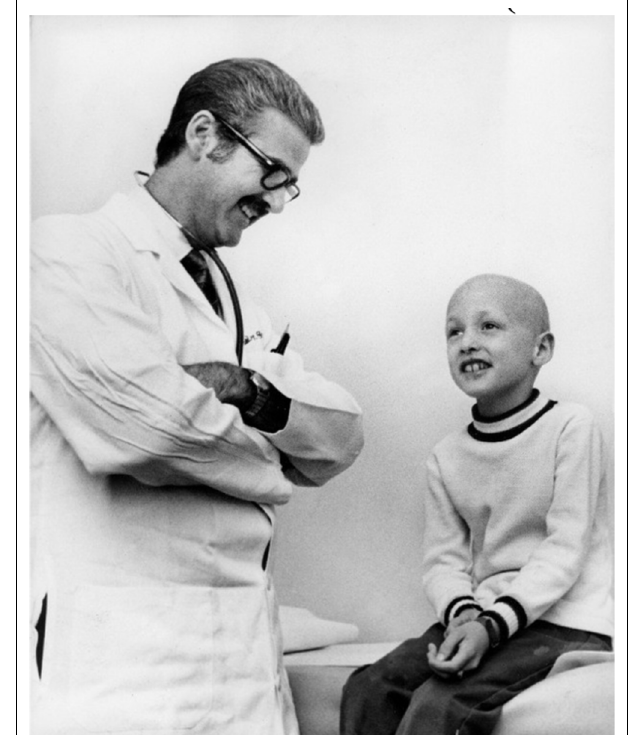
FIGURE 5 | Development of a successful combined chemotherapy approach for childhood acute lymphoblastic leukemia (ALL) that ultimately became a therapeutic model for the treatment of systemic cancers of many types. In 2012 the cure rate for childhood ALL is 90%. (Photo: Archive St. Jude’s Hospital). “November 12, 1970 – Dr. Rhomes J. A. Aur, of St. Jude Children’s Research Hospital, with Steven Ray of Jackson, Miss. who has been receiving treatment for leukemia for 2 years. Announcement of a 17% cure rate in leukemia was made at the hospital